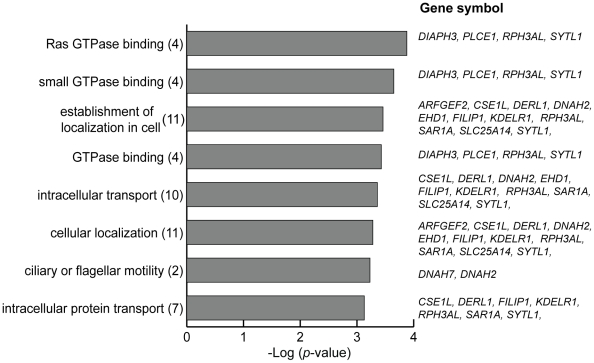
Biological characteristics of 88 progression-free survival-related genes.Significantly over-represented 8 gene ontology (GO) categories in GO-based profiling of 88 genes after multiple testing correction of the Benjamini–Hochberg false discovery rate method (FDR q-value<0.10). Over-represented GO categories were identified using all genes on Agilent platform as a background set of genes for the determining p-values. The actual number of the PFS-related genes involved in each category is given in parentheses.